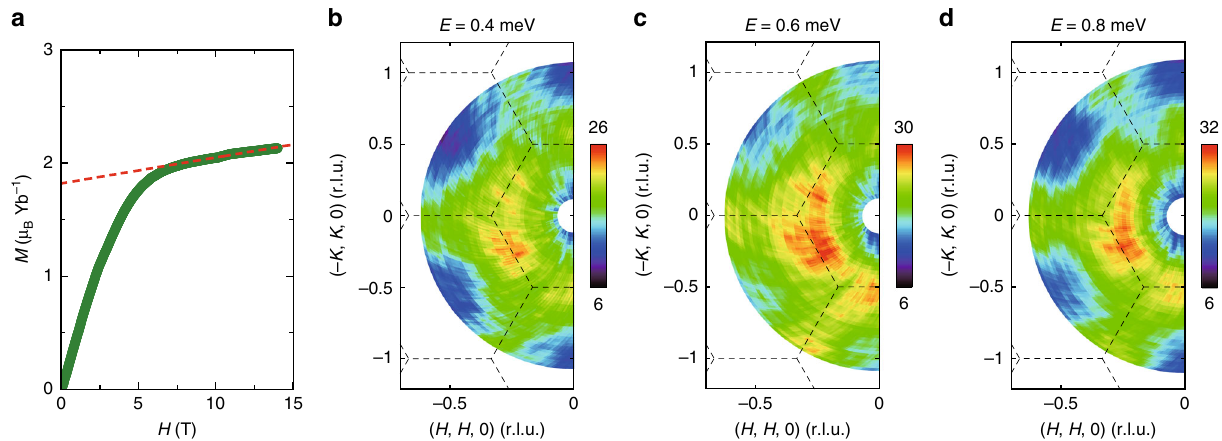
Fig. 1 Magnetization and spin excitations of YbMgGaO 4 under magnetic fi elds. a Magnetic fi eld dependence of the magnetization at T = 2 K 16 . The dashed line denotes the linear fi t of the magnetization above ~7 T. b – d Constant-energy images at the indicated energies under a magnetic fi eld of 2.5 T at 70 mK. The color bar indicates scattering intensity in arbitrary unit in linear scale. The dashed lines represent the Brillouin zone boundaries. The data were collected using the Flatcone detector on ThALES and corrected for neutron-beam self-attenuation using a similar method described in ref.